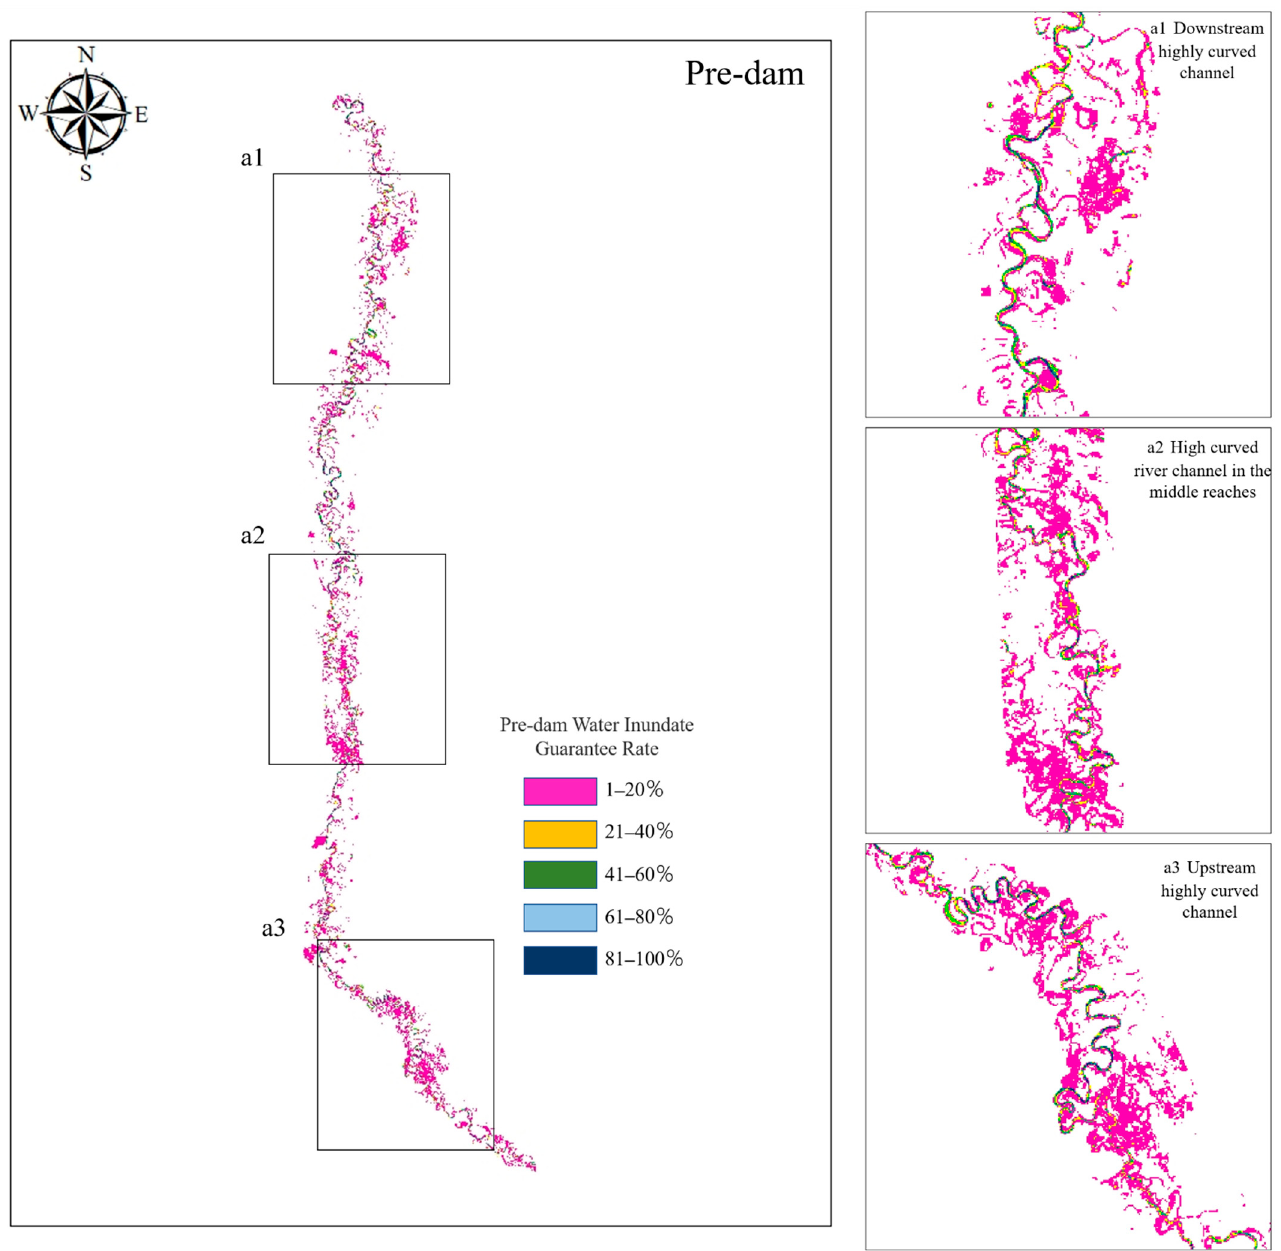
Figure 9. Pre-dam area distribution and typical change area under different inundation guarantee rates.